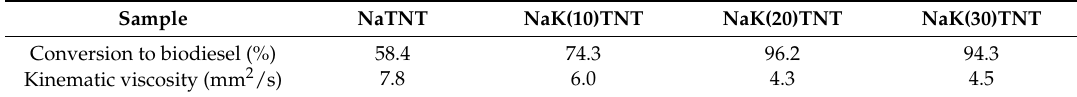
Table 12. Catalytic activity of the NaK(X)TNT (X refers to the percentage of the potassium loaded) samples.